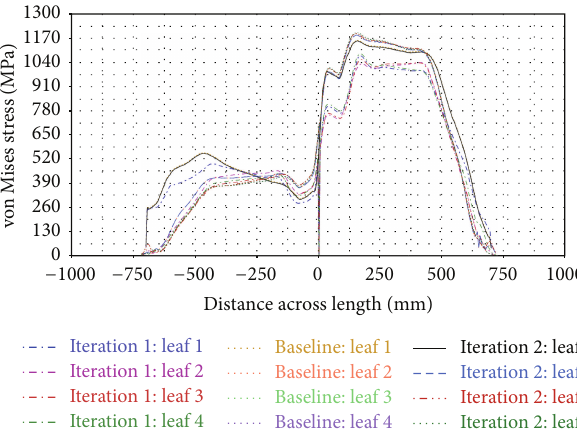
Figure 12: von Mises stress across length of wind-up loading.